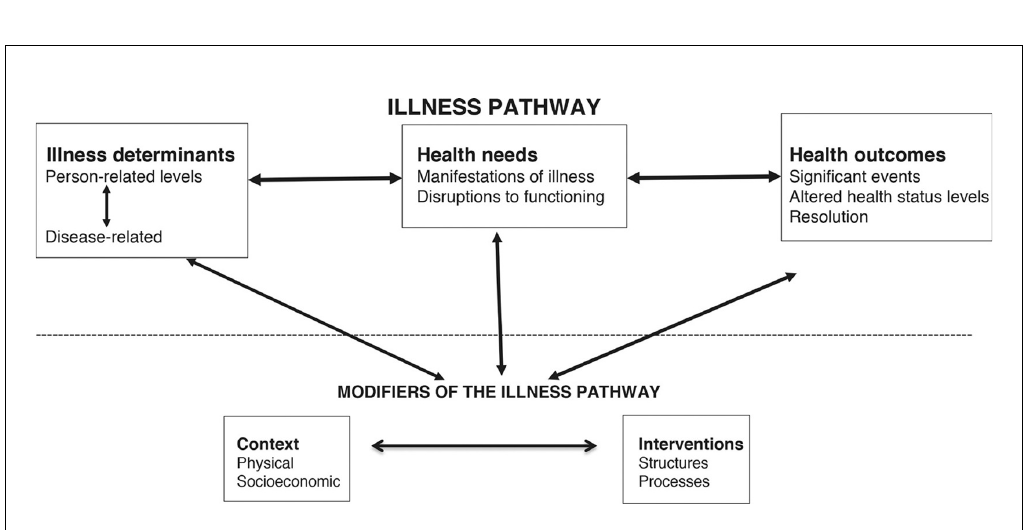
Figure 1. Configuration of the Leicester SEARCH (Systematic Exploration and Analysis of Relationships Connecting Health variables in populations) conceptual